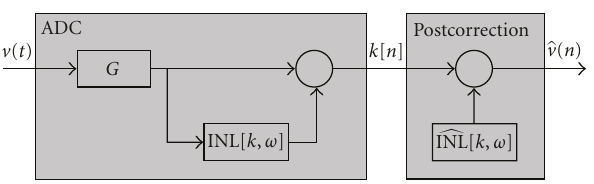
Figure 2: Postcorrection of an ADC by adding a correction term. The block G includes analog preprocessing, sample and hold, and quantization.